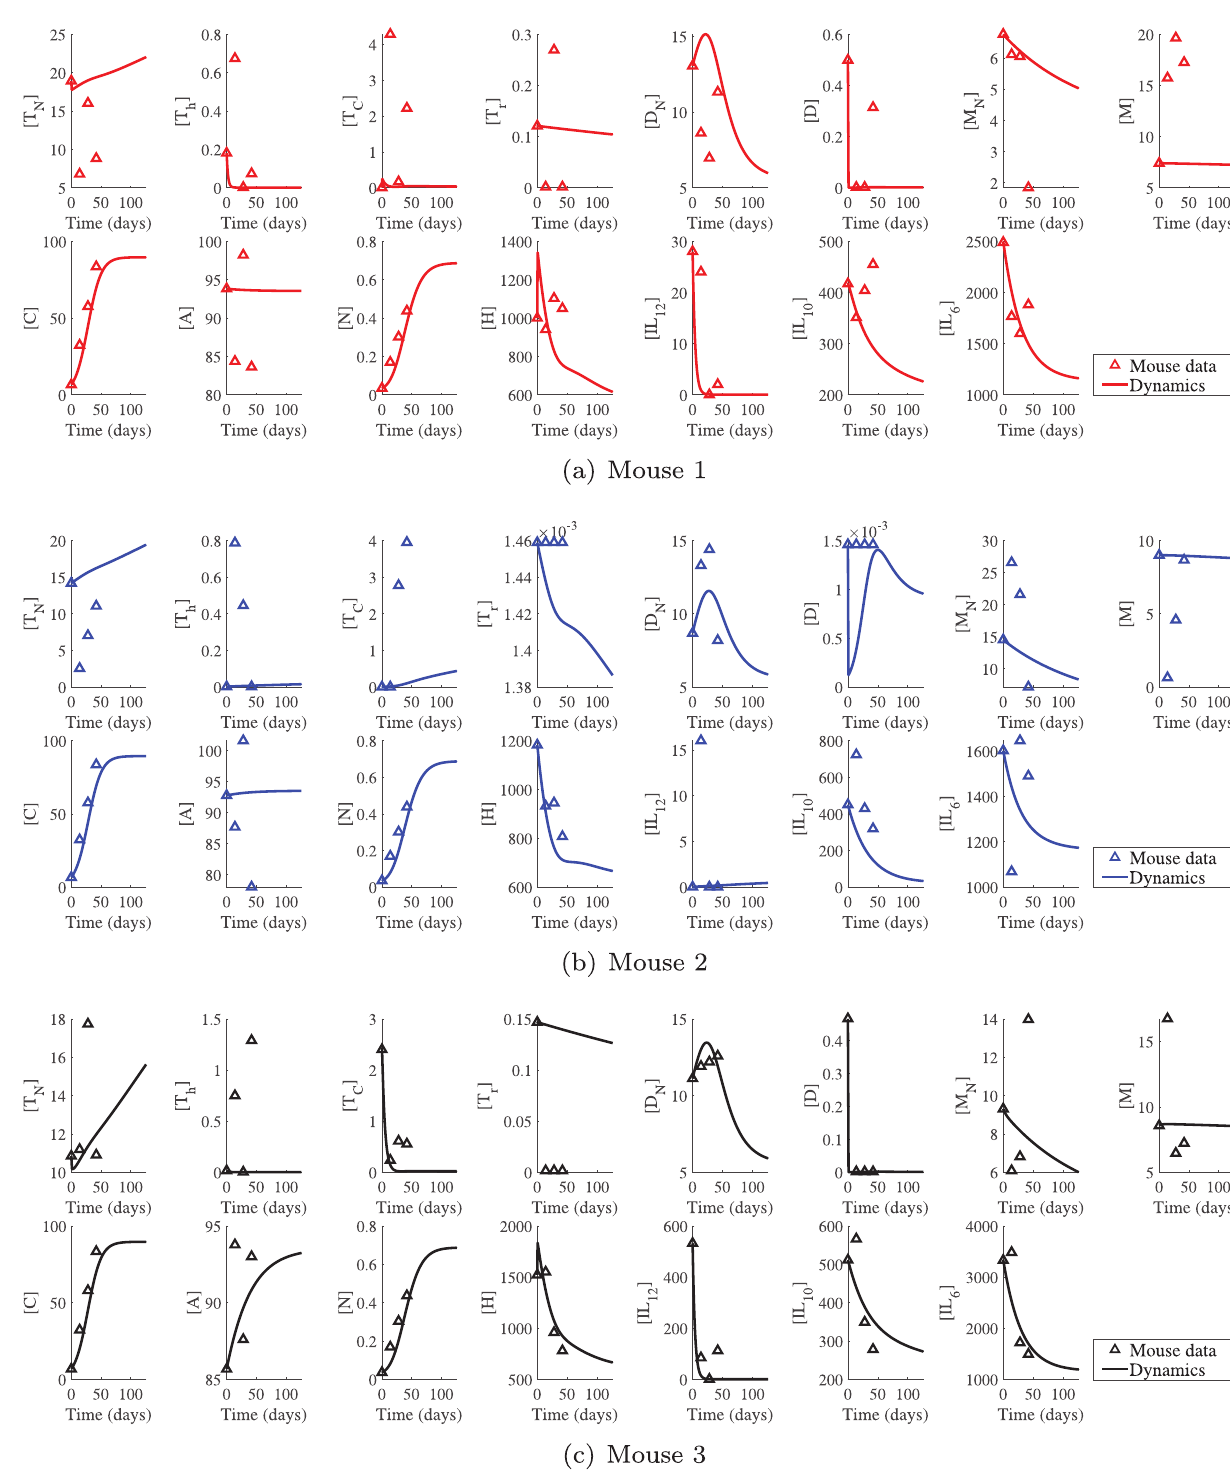
Fig 3. Comparison of the dynamics and mouse data. By solving the system of ODEs, the mouse data are compared to the values estimated using the optimal parameters obtained from the least-squares optimization. Time zero corresponds to 6 weeks which is the beginning of the mice data sampling.